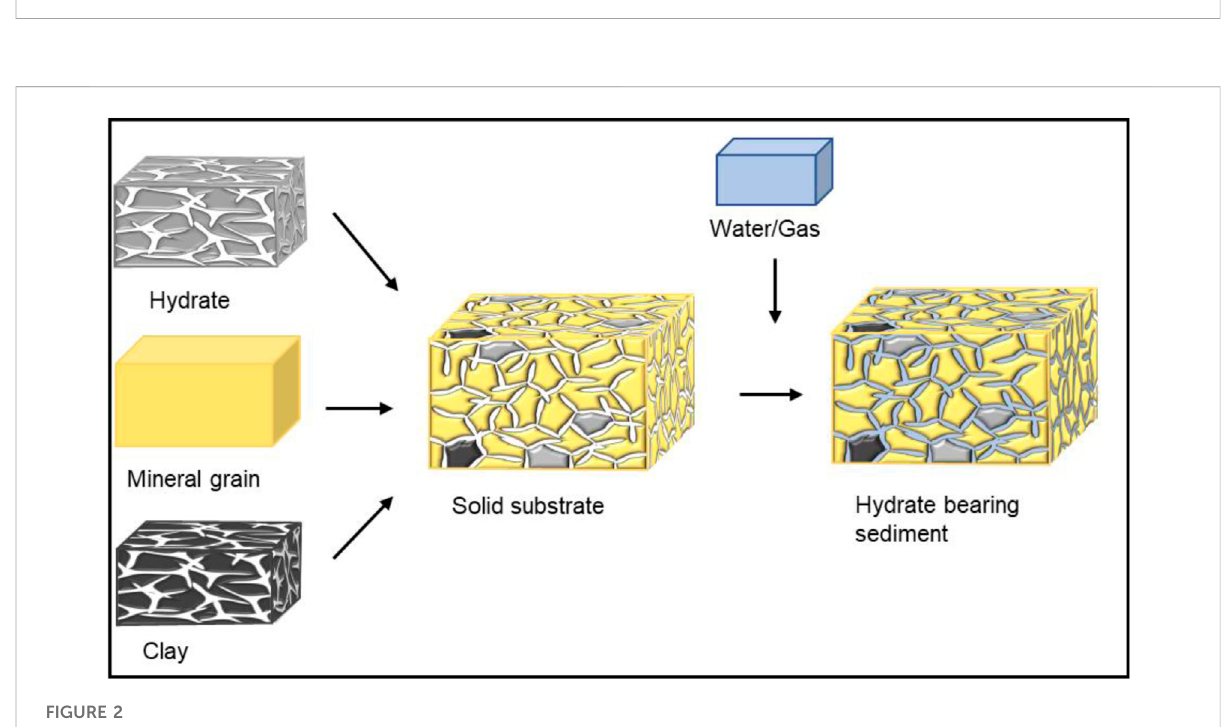
Diagram showing hydrate as part of the solid frame